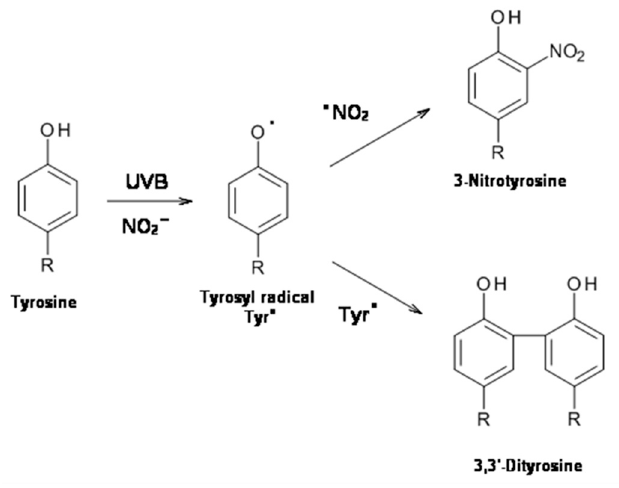
Figure 2. UVB-induced 3-nitrotyrosine and 3,3 ′ -dityrosine formation.